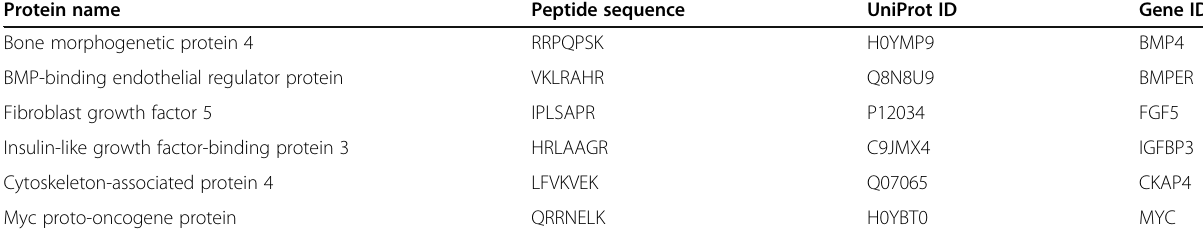
Table 2 Protein interactions identified by STICH version 5.0 related to bone morphogenetic protein